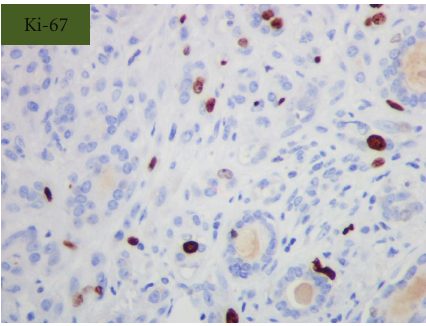
Figure 6: Myoepithelial stains, S-100 (original magnification × 400).